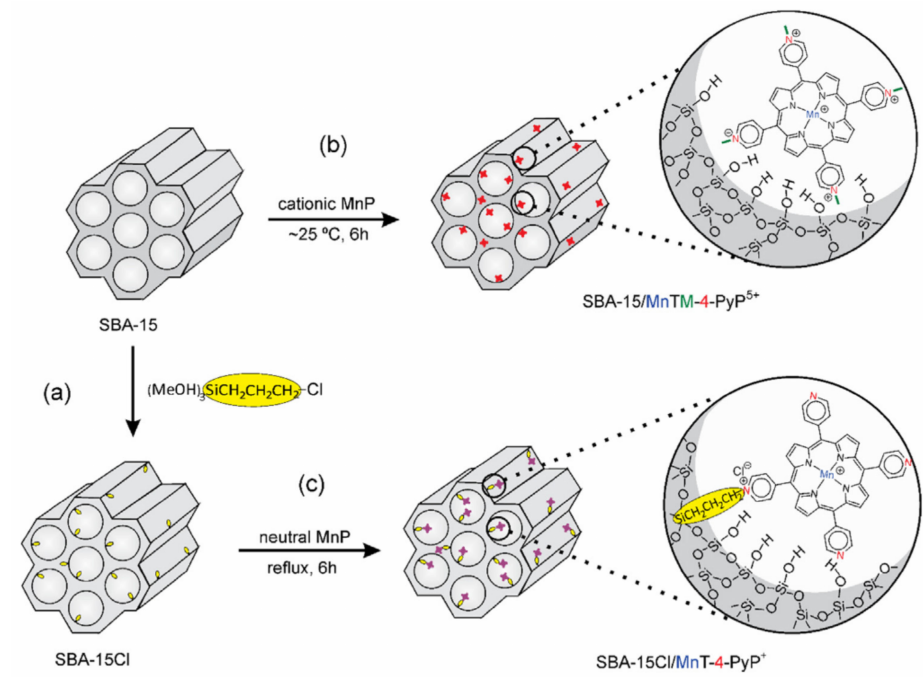
Figure 13. Schematic representation of the synthetic routes for ( a ) preparation of support SBA-15Cl by the silanization of SBA-15 with CPTS, ( b ) immobilization of MnTM-4-PyPCl5 on SBA-15 by electrostatic interaction, and ( c ) anchorage of MnT-4-PyPCl on SBA-15Cl by covalent bonding. The two classes of heterogenized catalysts are illustrated with the para MnP isomers. Reproduced with permission from Reference [135]. Copyright (2016) Elsevier